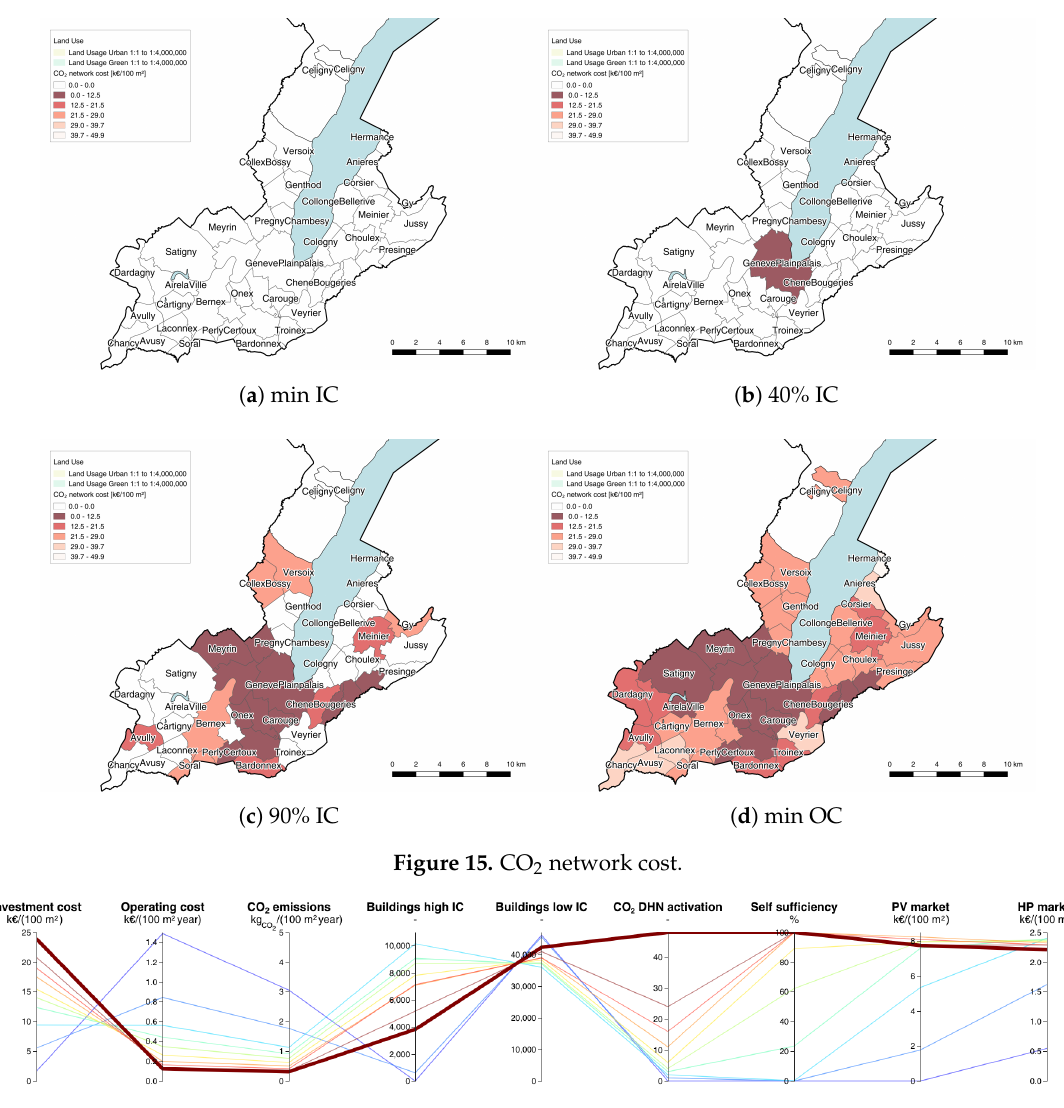
Figure 16. Parallel coordinate representation of the canton